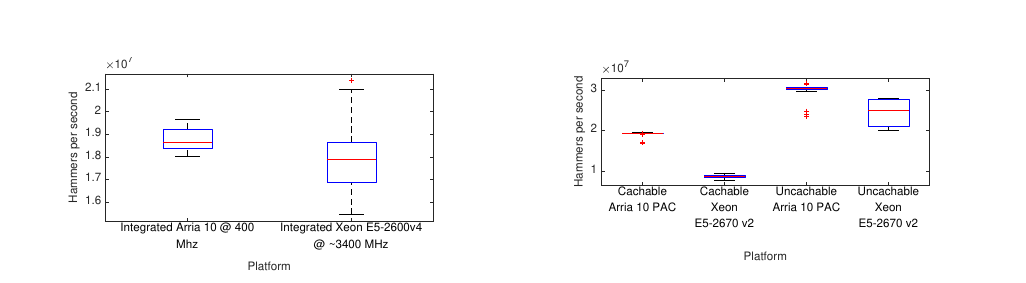
Figure 8: Distributions of hammering rates (memory requests per second) with cachable and uncachable